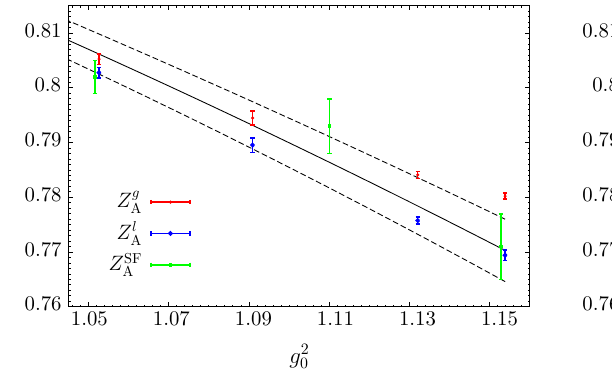
Fig. 3 Comparison of different Z A determinations for N f = 2, obtained from WIs in the standard SF and from universality relations in the χ SF. The effect of the perturbative one-loop improvement of the χ SF results is also shown (right panel). The χ SF results are those of Table 4. The individual SF points are taken from Refs. [8,44], and are slightly displaced on the x -axis for better clarity. The solid black line